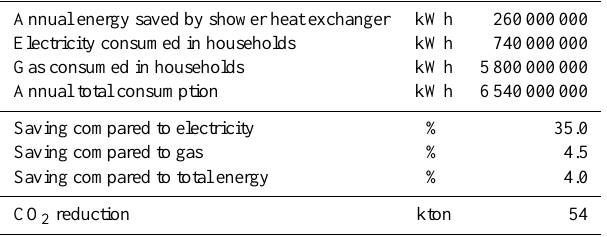
Table 6. Estimation of energy recovery and CO 2 emission reduc-